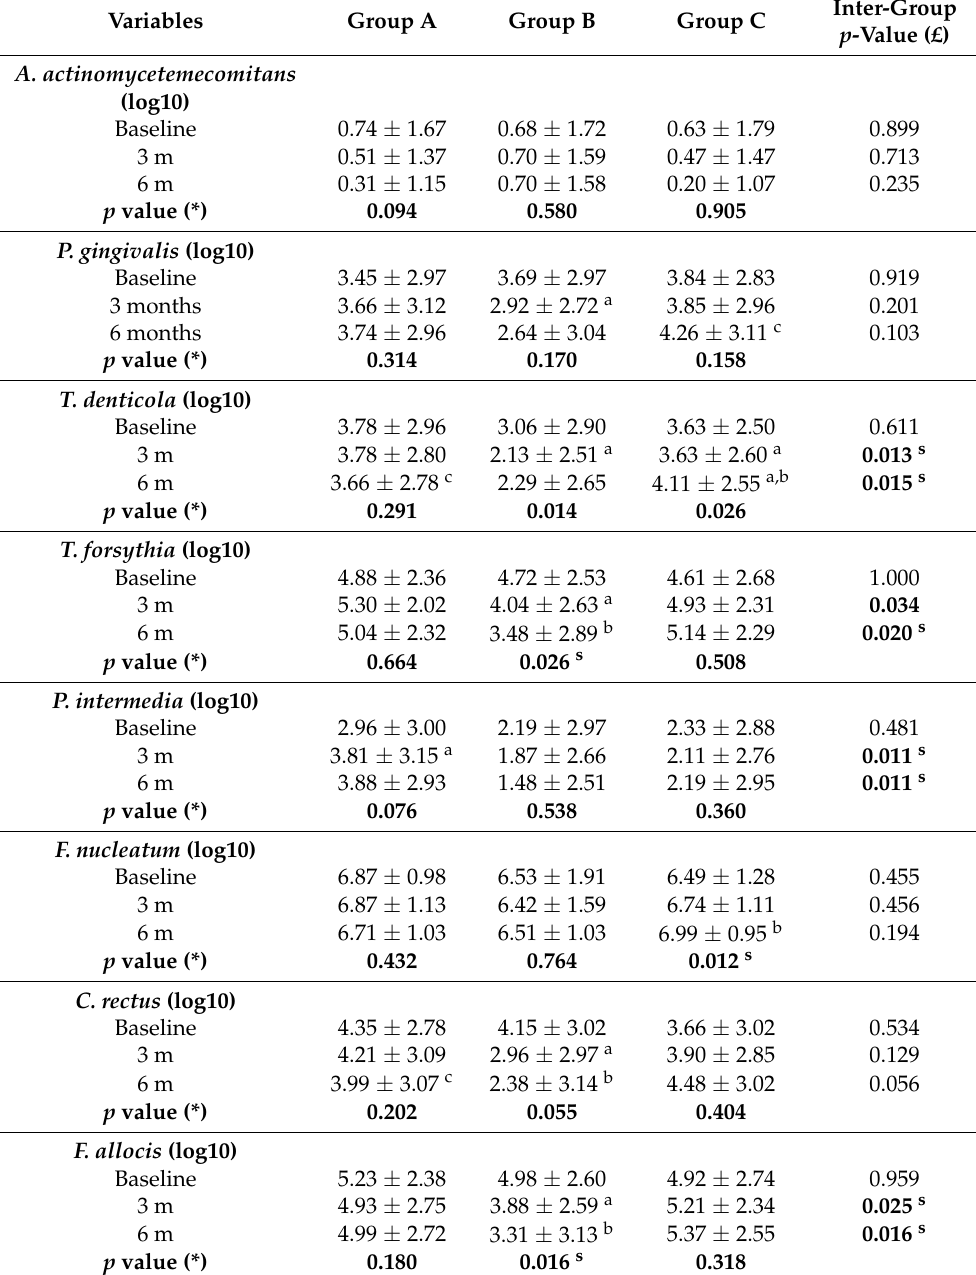
Table 6. Mean counts ( ± SD) of eight periodontal pathogens in the three treatment groups (A: PDT, B: LDD, C: control) at baseline and after 3 and 6